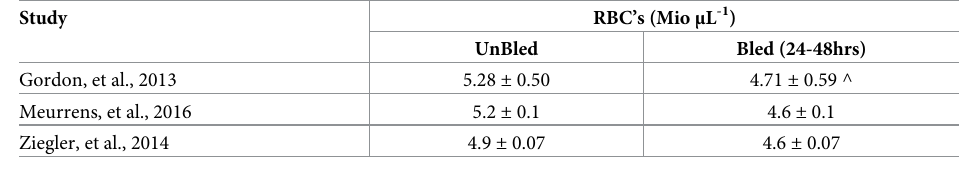
Table 7. RBC’s pre and post donation (Unbled and bled) values over varying time frames.